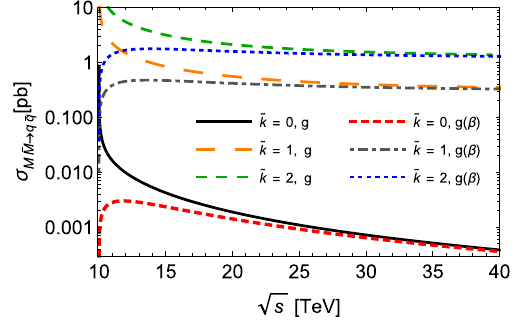
Fig. 3 Total cross section for spin-half monopole–antimonopole pair annihilation M ¯ M → q ¯ q as a function of the center-of-mass energy √ s , at the fixed value of the monopole mass M = 5 TeV, but taking a velocity (β) dependent coupling, g (β) , and different values of the normalized parameter ˜ κ = κ M